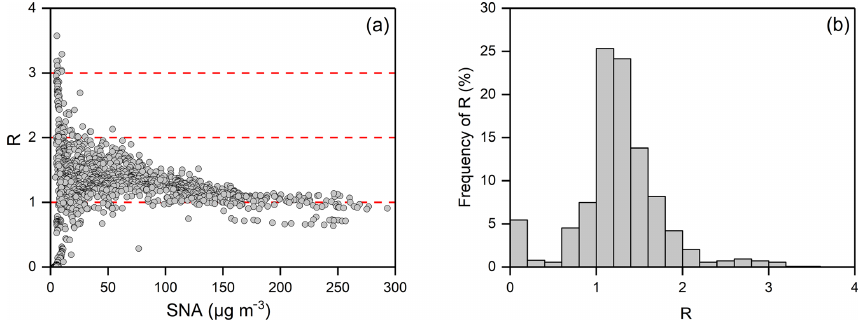
Figure 4. (a) The observed molar ratio ( R ) and the concentrations of SNA in PKUERS in December 2015 and December 2016. (b) The frequency of R during the same